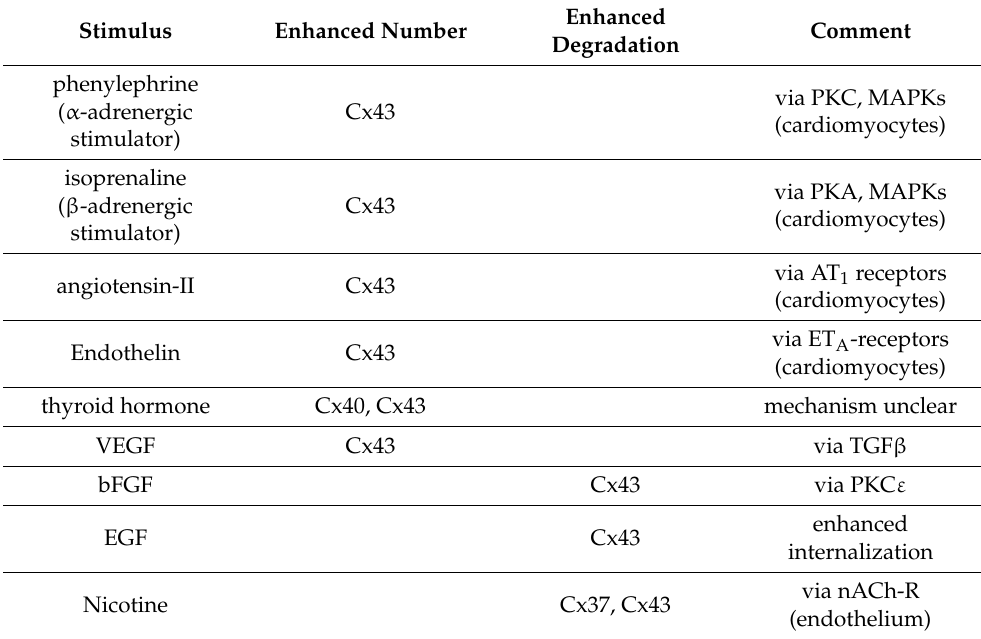
Table 2. Pathways regulating the expression of cardiac